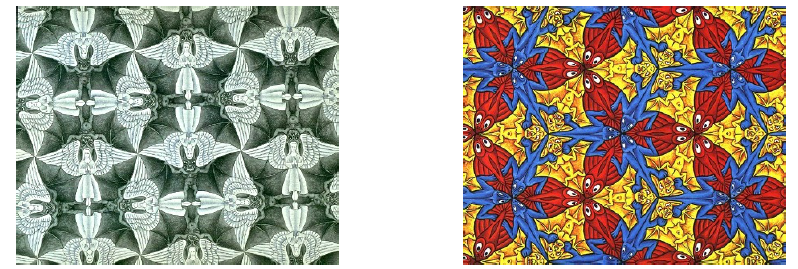
Figure 1 . A tessellation of the (cid:13)at surface plane covered with equilateral triangles. The shift of the whole plane over the distance AB, will cover the underlying pattern again. This is a translation of the plane. We can also turn the duplicate through 60 degrees about the point C, and we see that it covers the original pattern exactly. This is a rotation . Also after a re(cid:13)ection in the line PQ, the pattern remains the same.